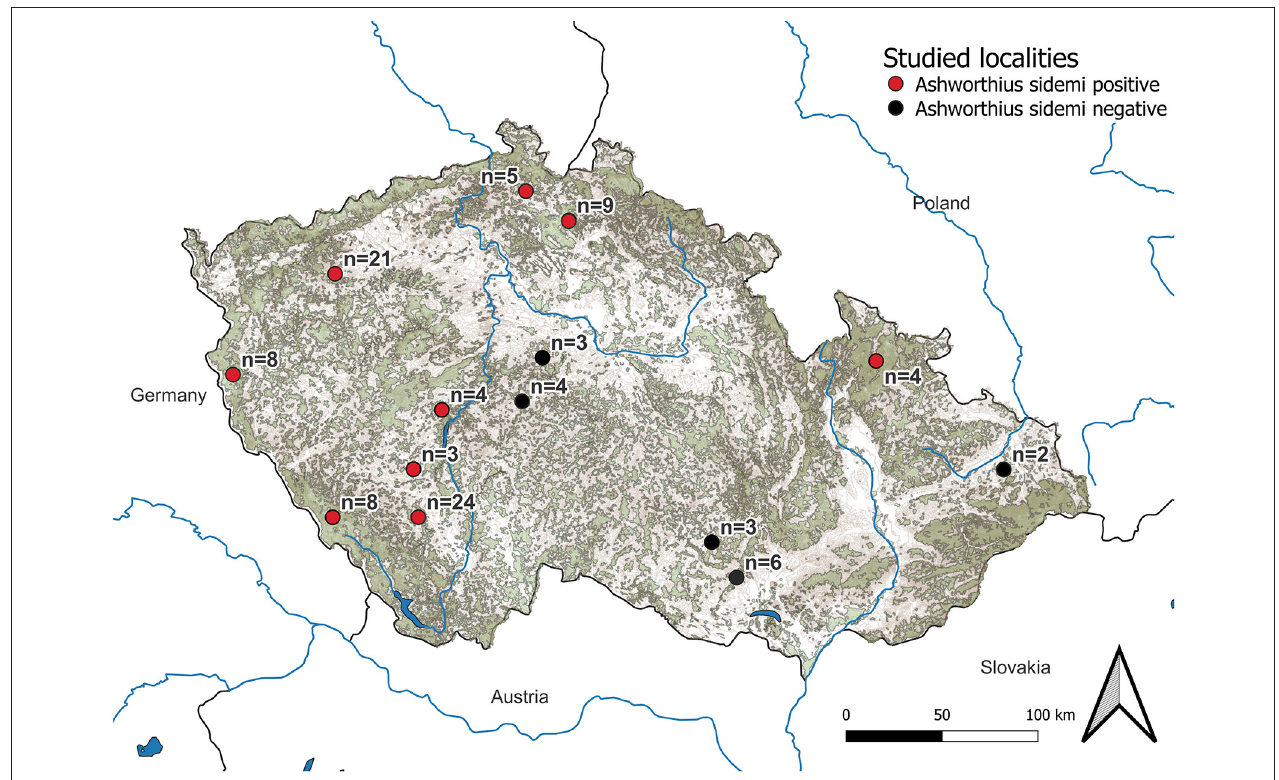
FIGURE 1 | Map of localities investigated. Forest covers are represented in khaki green color and mountains are presented in brown color. The number of examined cervid hosts at each locality is listed as well.